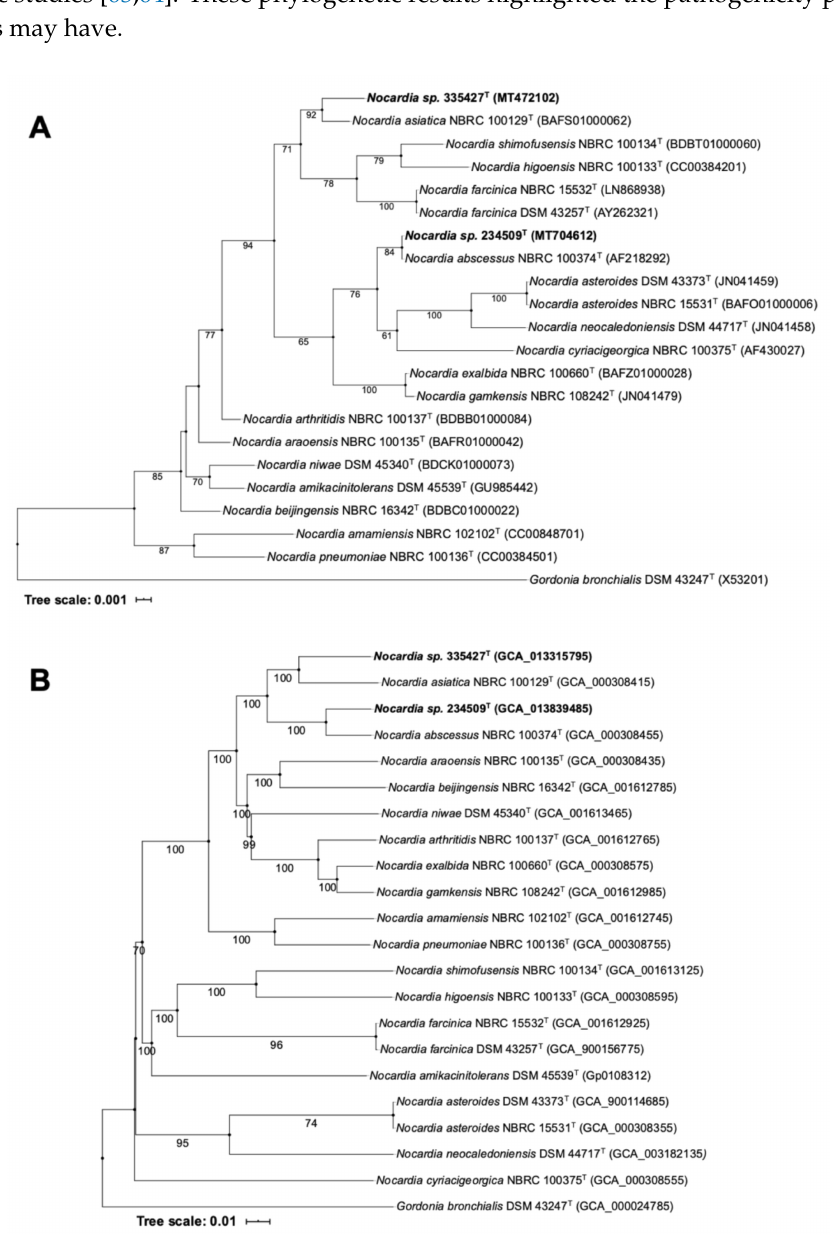
Figure 1. Phylogenetic trees based on 16S rRNA gene ( A ) and genome sequences ( B ) showing the phylogenetic position of isolates 335427 T and 234509 T within the evolutionary radiation of the genus Nocardia and their relationship with one another and with their closest phylogenetic